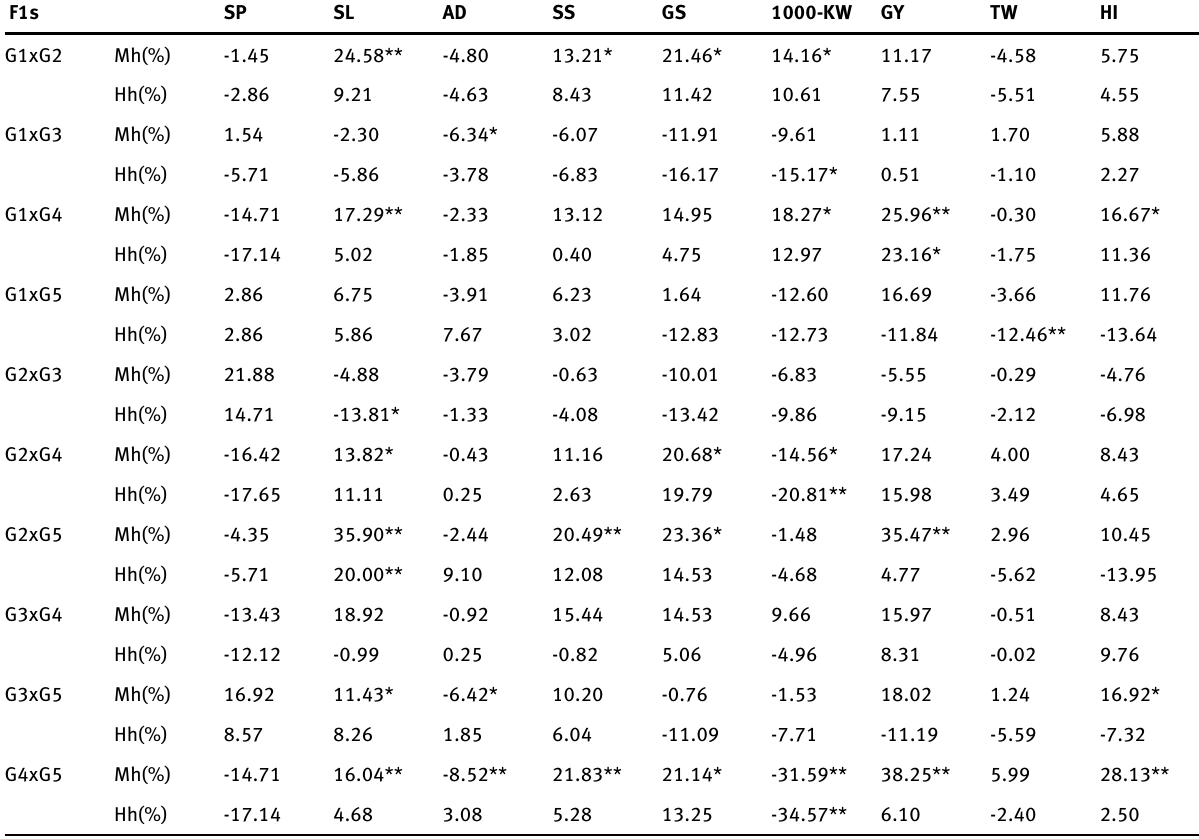
Table 5: Estimation of percentage heterosis (Mh %) and heterobeltiosis (Hh %) for nine agronomic traits in F1